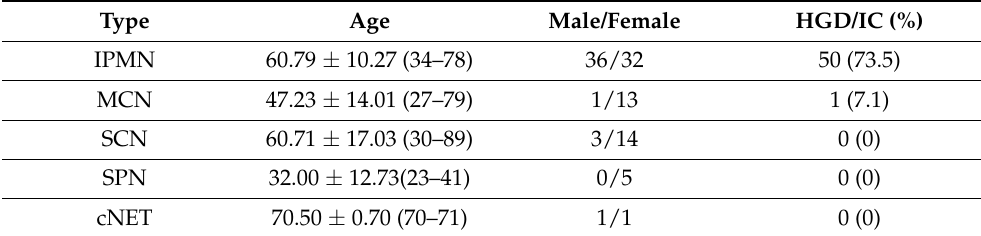
Table 1. Distribution of patients by type of pancreatic cystic neoplasm, basic demographics, and final surgical pathology confirmation of malignancy